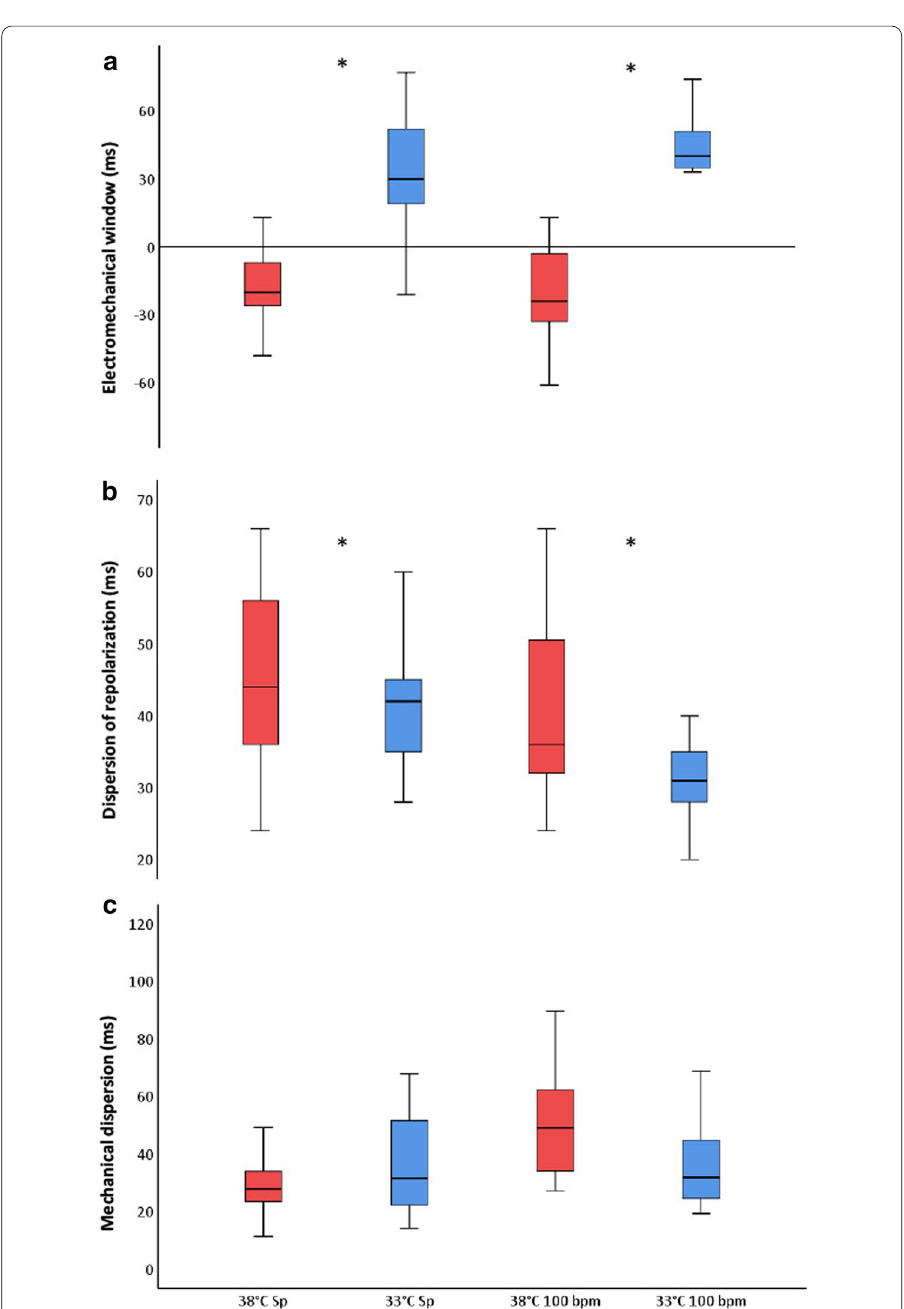
Fig. 2 Electromechanical window, dispersion of repolarization and mechanical dispersion. Electromechanical window ( a ), dispersion of repolarization ( b ) and mechanical dispersion ( c ) during normothermia (38 °C) and hypothermia (33 °C) at spontaneous (Sp) and heart rate 100 bpm. The plots are computed from 13 ( a ) and 14 ( b , c ) animals at spontaneous heart rate, and 12 ( a )/13 ( b , c ) animals for paced heart rate. Asterisk indicates statistical significance, p <